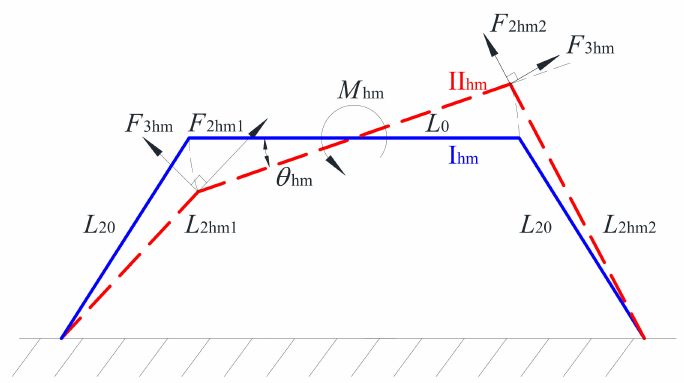
Figure 8. Schematic diagram of horizontal